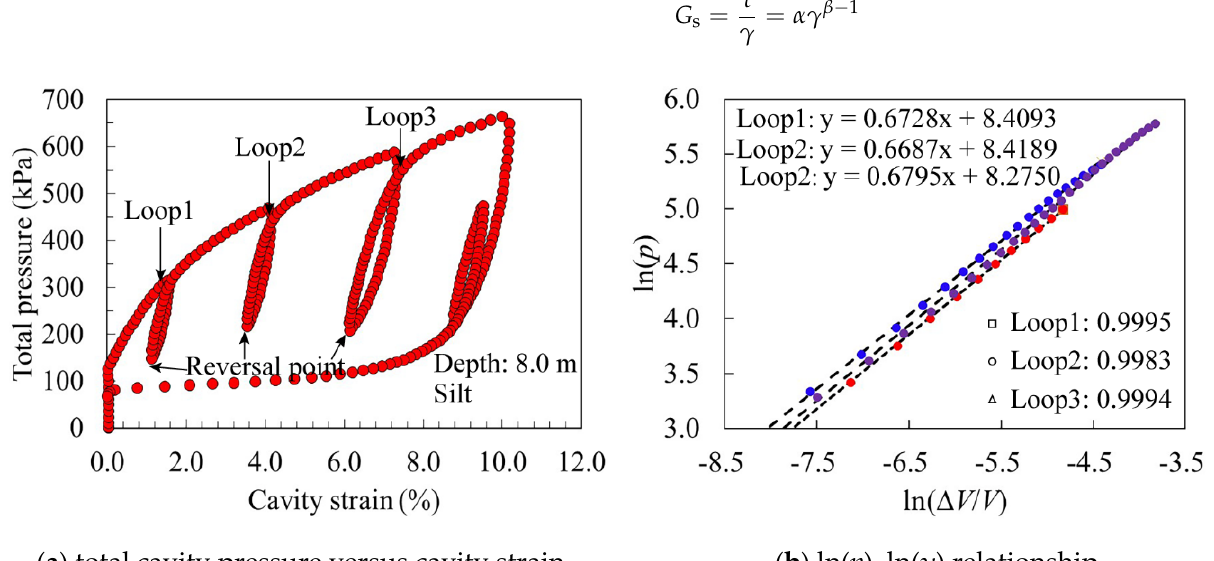
Figure 3. A representative SBPM test result curve.